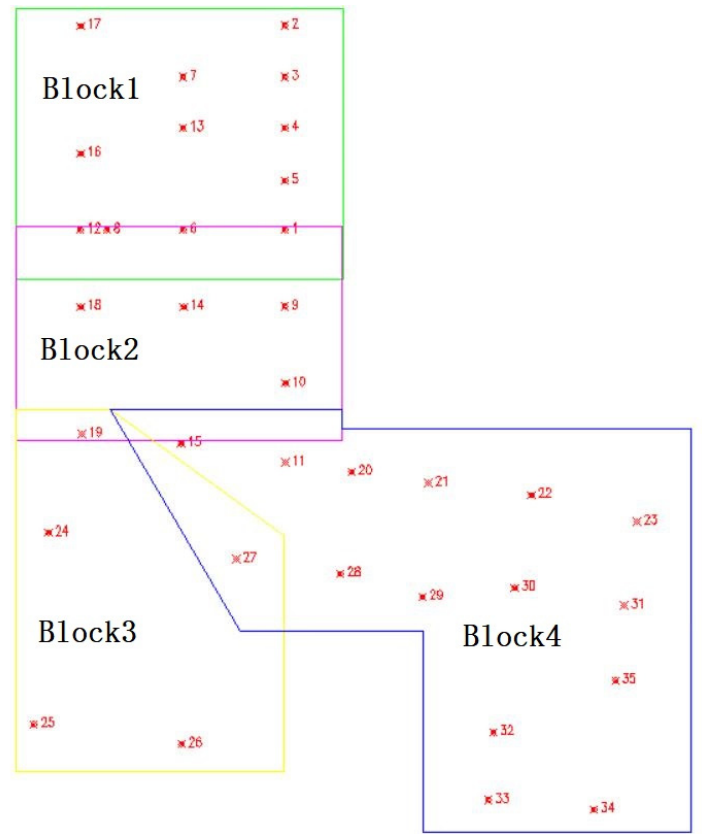
Figure 5. Control network distribution.